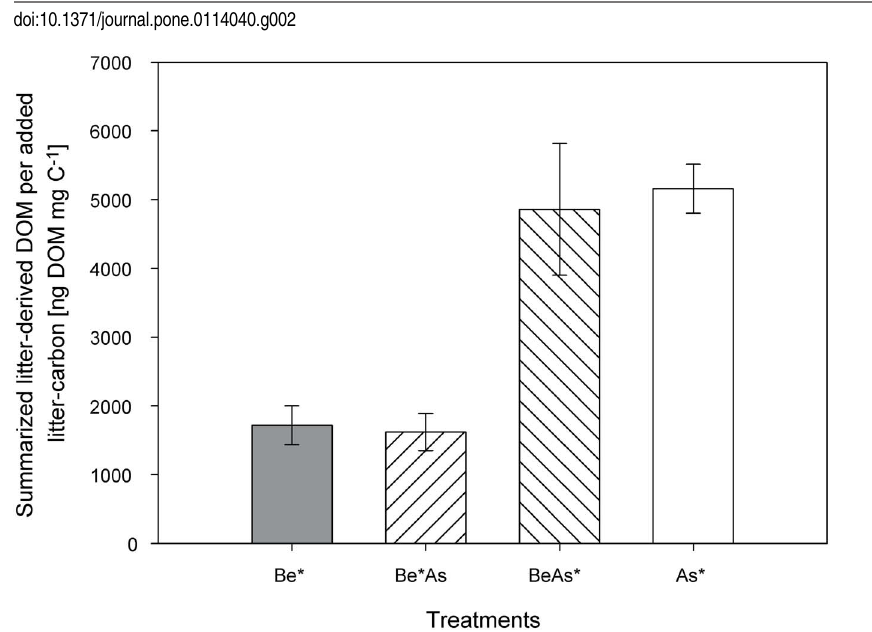
Figure 3. Determined amounts ( ¡ standard error) of litter-derived DOM per added litter-carbon summarized over the whole experiment for treatments with only labeled beech (Be*), labeled ash (As*) and mixed litter treatments (Be*As, BeAs*). The litter-derived DOM was significantly lower in the labeled beech (Be*, Be*As) treatments in comparison to the labeled ash (As*, BeAs*) treatments (p , 0.01, n 5 6, one- way ANOVA followed by Tukey’s HSD post hoc test).